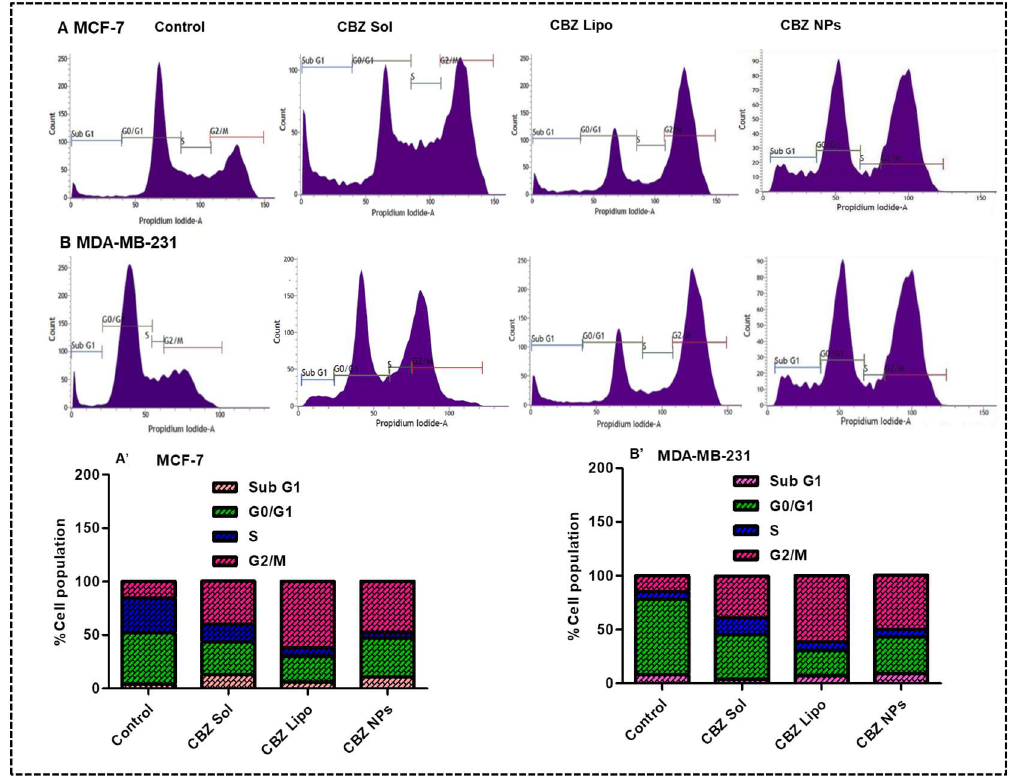
Figure 6. Inhibition of cell cycle and DNA damage checkpoints on MCF-7 and MDA-MB-231 cell lines: A and B representing flow cytograms of different phases of arrest in the cell cycle in MCF-7 and MDA-MB-231 cell lines treated with CBZ micellar solution, CBZ liposomes, and CBZ NPs, respectively, in comparison with control. A’ and B’ represent the percentage of cell population at different phases of arrest in MCF-7 and MDA-MB-231 cell lines treated with CBZ micellar solution, CBZ liposomes, and CBZ NPs, respectively, in comparison with control.